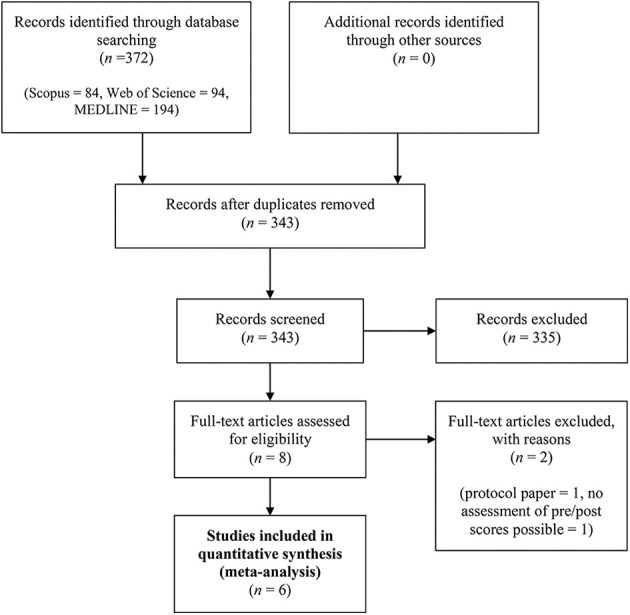
PRISMA flowchart of screening, exclusion, and inclusion criteria.